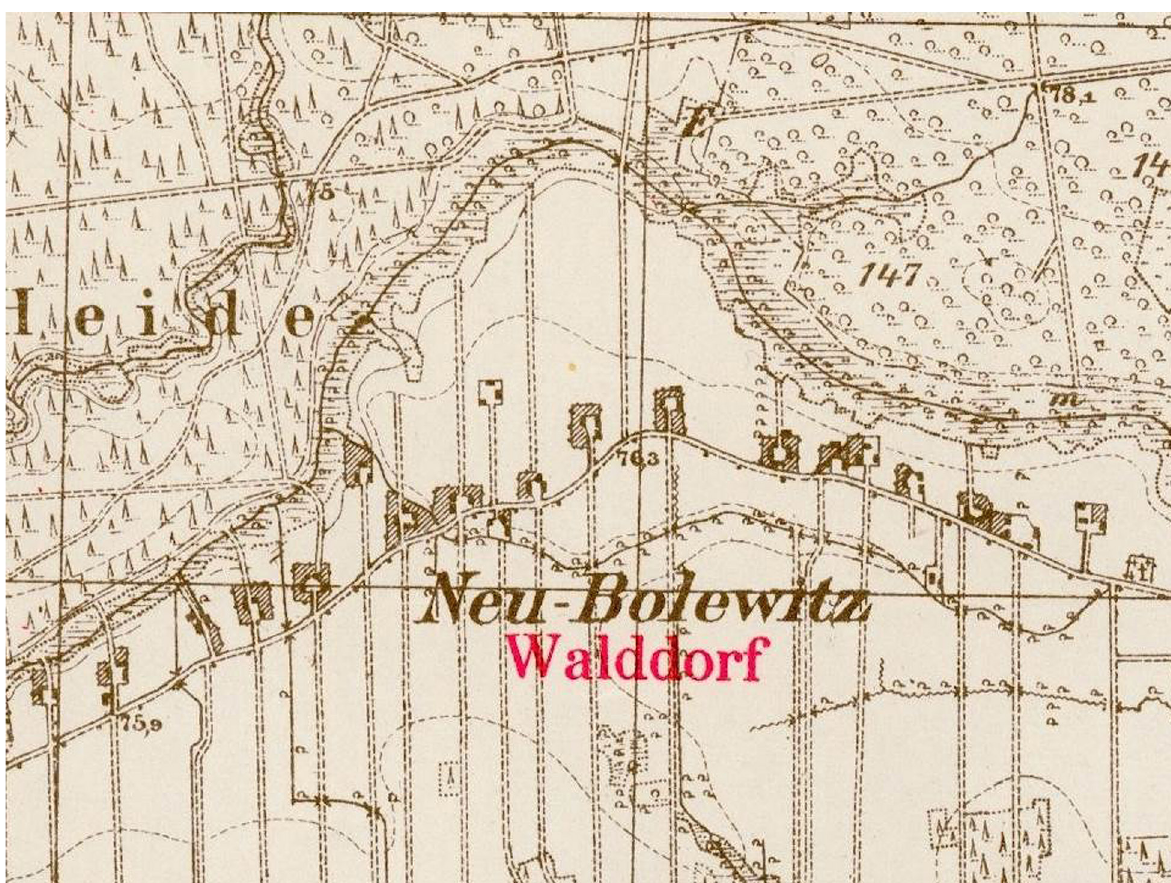
Fig. 2. One-row bog village as an example of Dutch law settlement. source: Messtichblätter, 3662